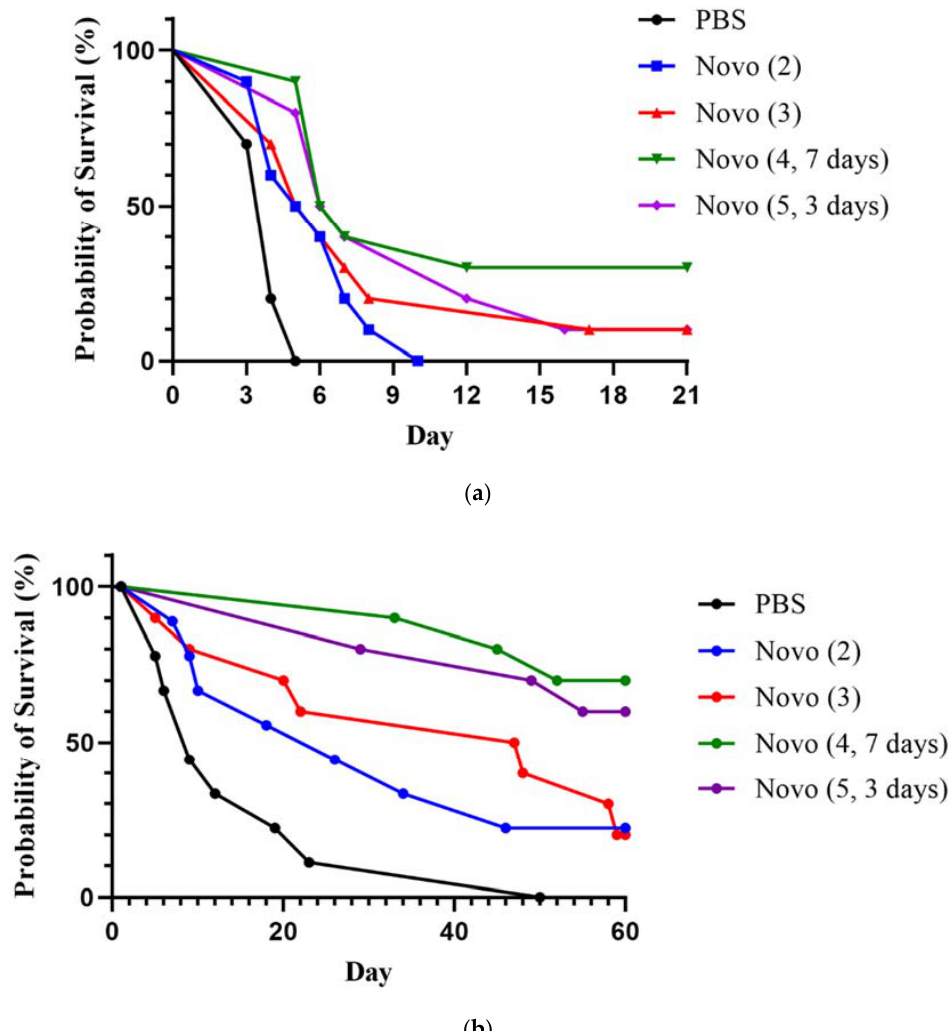
Figure 3. The effects of Novo treatment on mice infected with B. anthracis or B. pseudomallei by an inhalational route. ( a ) A/J mice ( n = 10/group) were challenged intranasally with 8.6 × 10 5 spores of